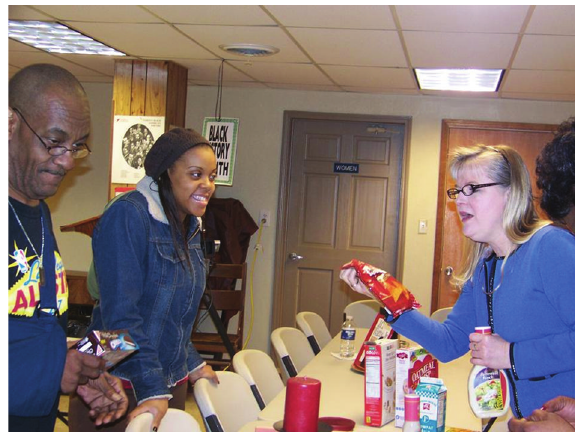
Figure 2: Demonstration of food servings and calory content meas- urement